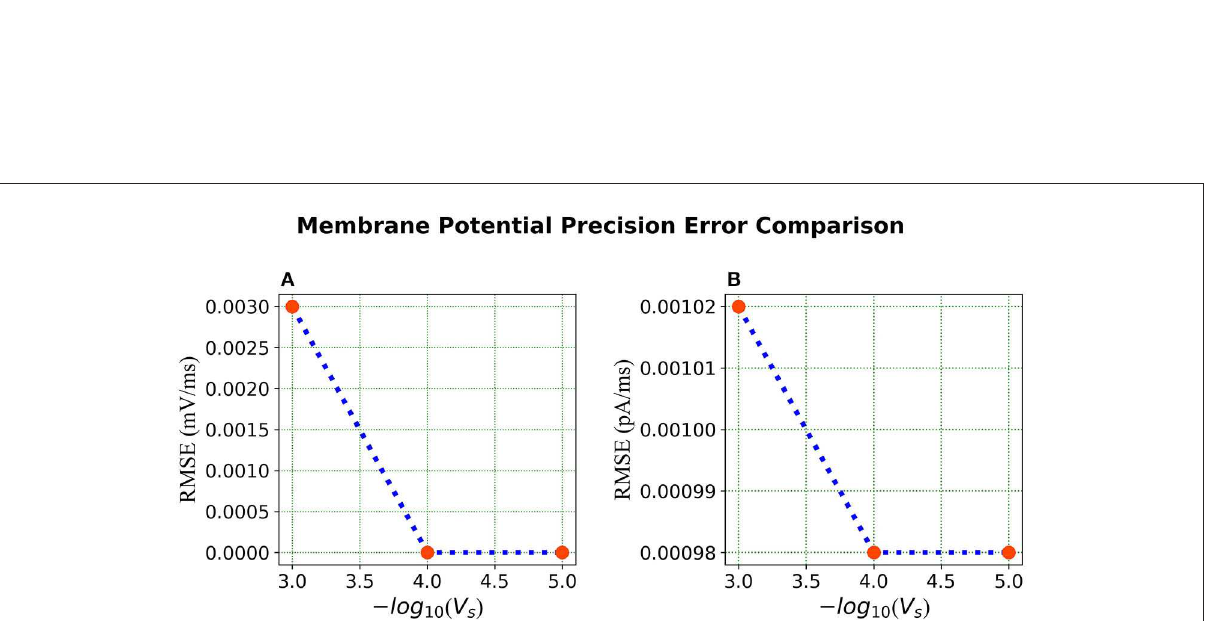
FIGURE9 Error comparison for different membrane potential precisions— (A) Membrane potential error. (B) Current error. In both panels, the RMSE for the corresponding state is plotted against the – log of the voltage scale V s